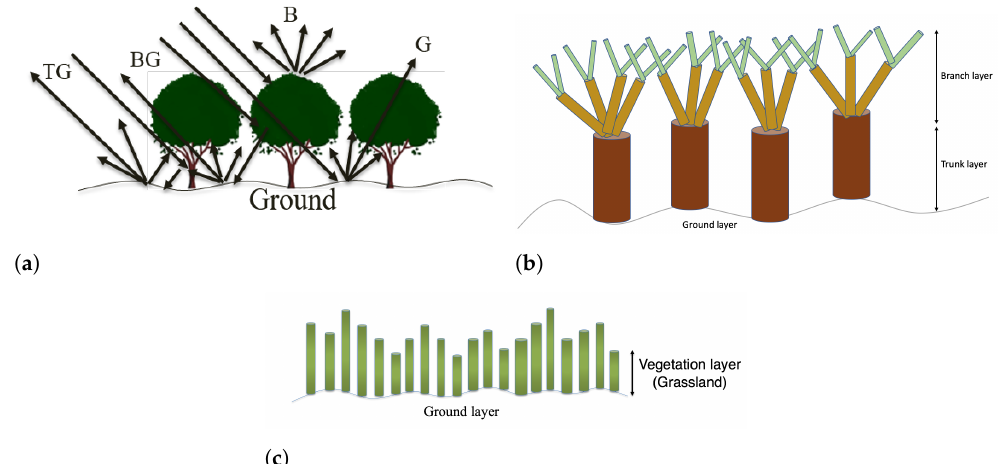
Figure 1. SSBM scattering mechanisms and vegetation geometry. ( a ) Scattering mechanisms: ground (G), branch (B), branch-ground (BG), and trunk-ground (TG). ( b ) Woody vegetation geometry, which consists of three layers and different scattering components. ( c ) Grassland vegetation geometry, which consists of two